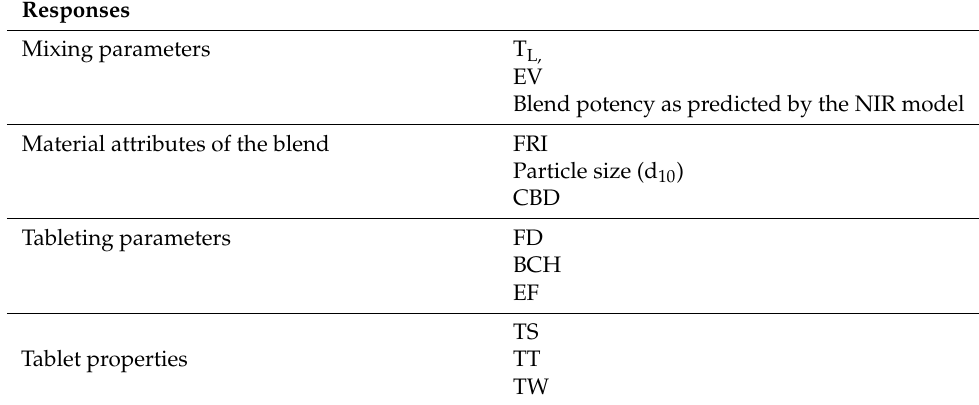
Table 1. Overview of considered responses, where HUM, IMP and THR were adjusted as input